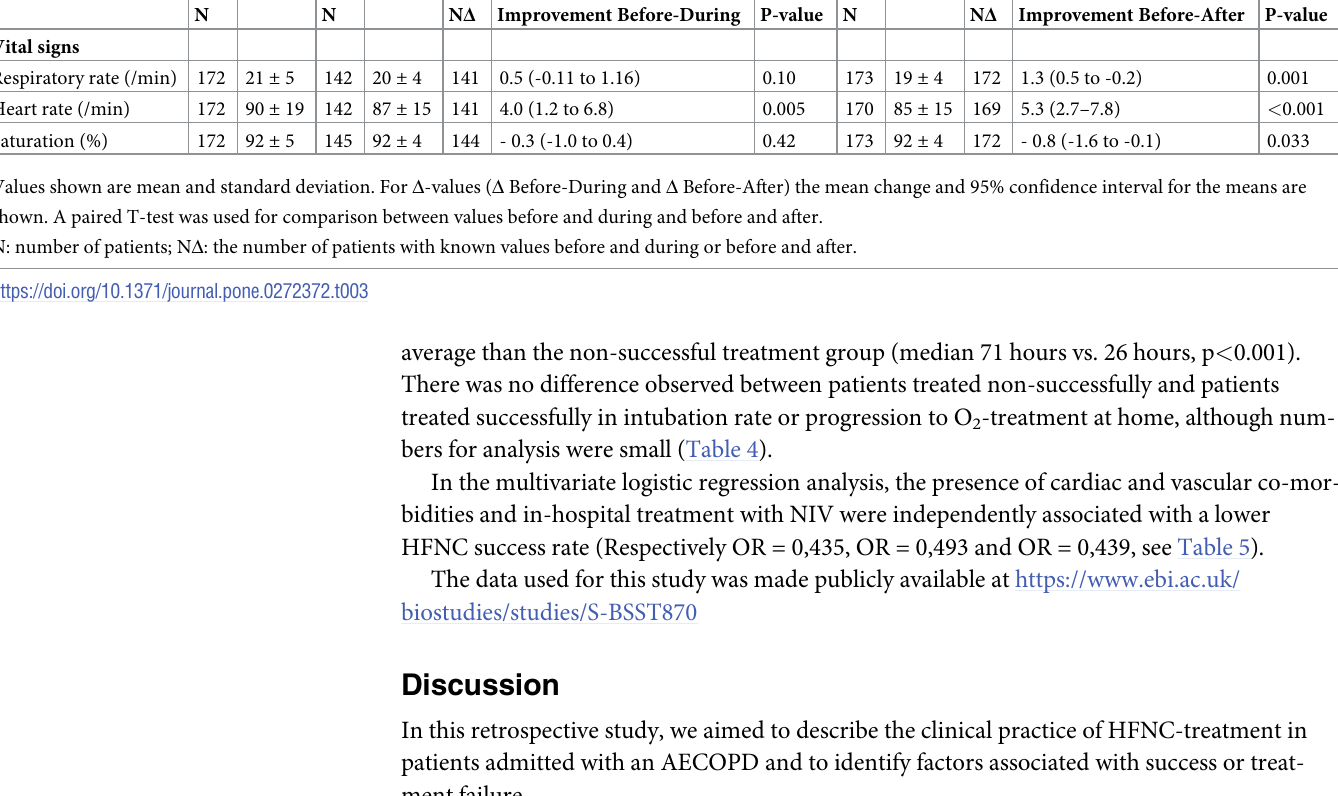
Table 3. Mean values before, during and after treatment with the HFNC. Before HFNC-